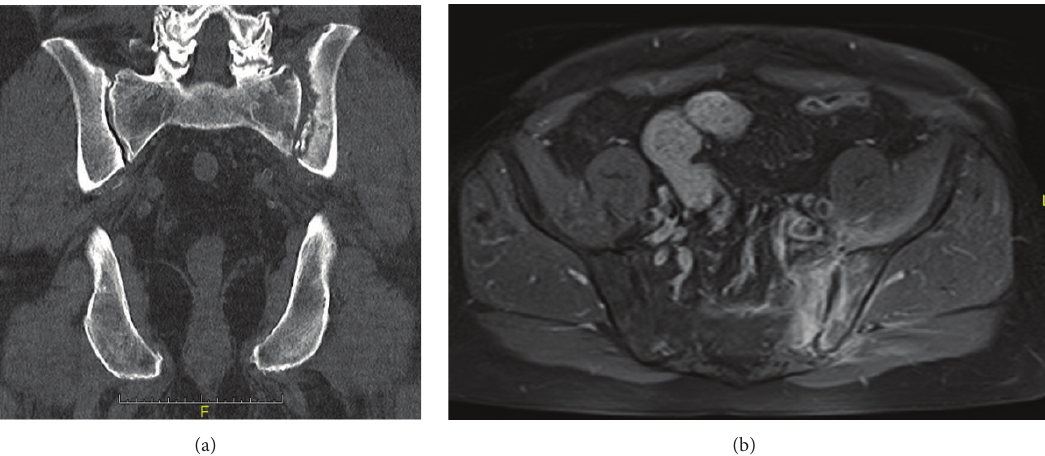
Figure 5: Control CT and MRI of the pelvis 2 months later: osteolytic destruction of the massa lateralis with fluid around the piriformis muscle and the ilium